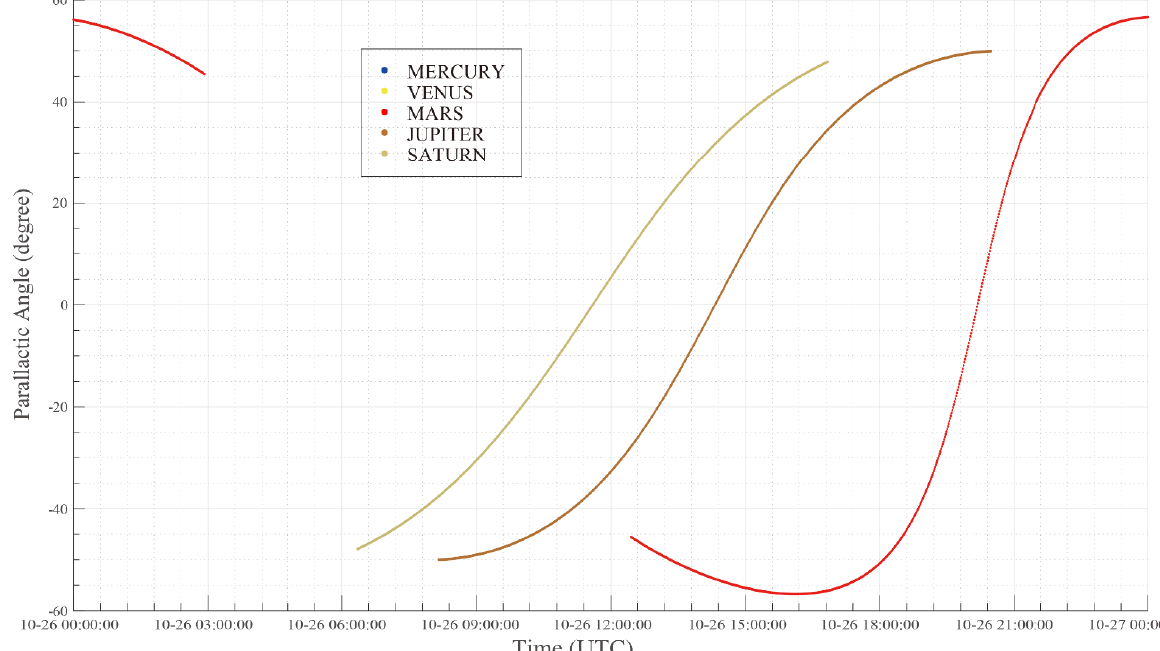
Figure 11. Parallactic angles of PAST targets during OBW . The large gap in the middle of the red line is the result of the OBW of Mars.